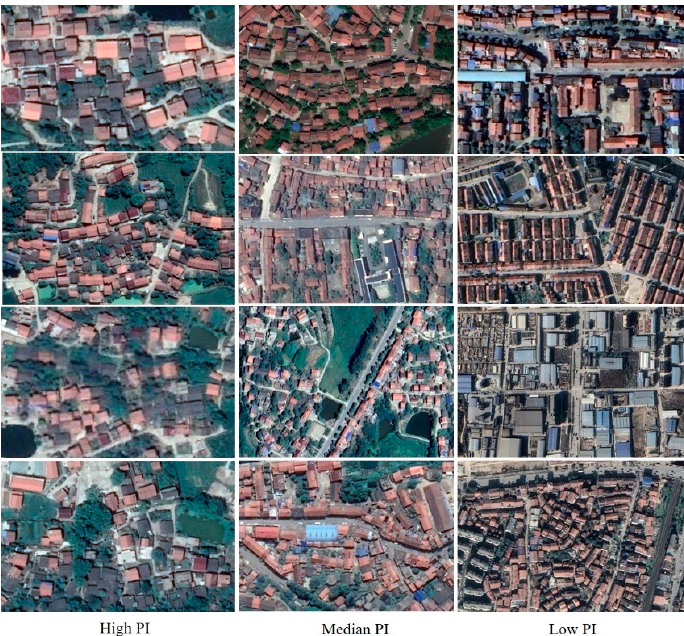
Figure 7. Image captures from high-resolution satellite imagery (0.26 m) showing suburban areas that have different levels of PI.